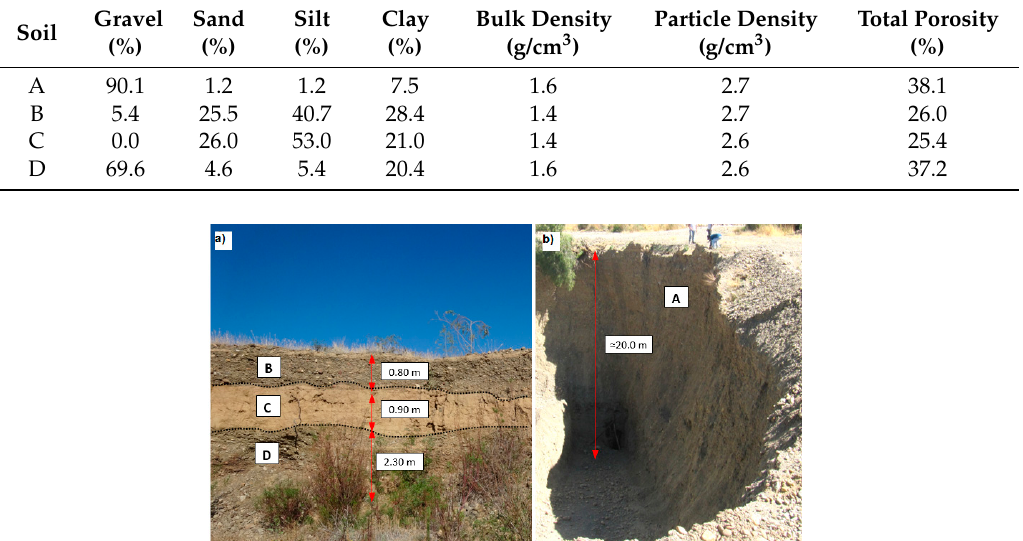
Table 1. ERT surveys with RMS error lower than 10%. Where Res. stands for resistivity and I.P. for induced polarization.